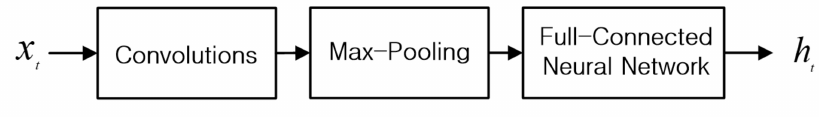
Figure 1. Convolution Neural Network (CNN).